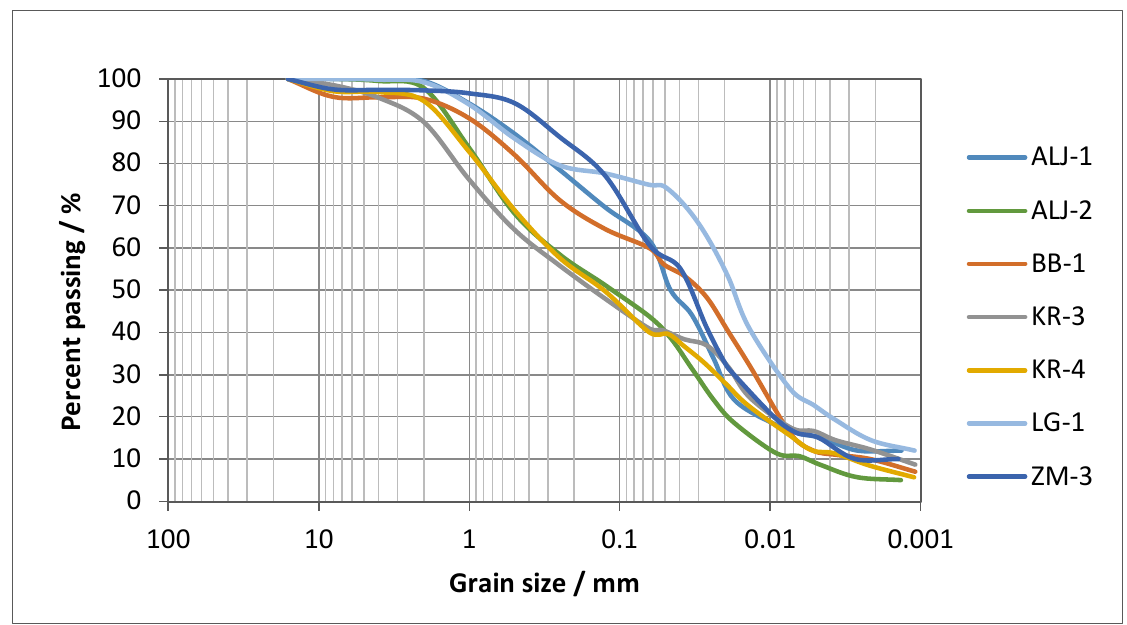
Figure 3. Grading curve of soil samples from traditional rammed earth houses from the area of eastern Croatia [28].